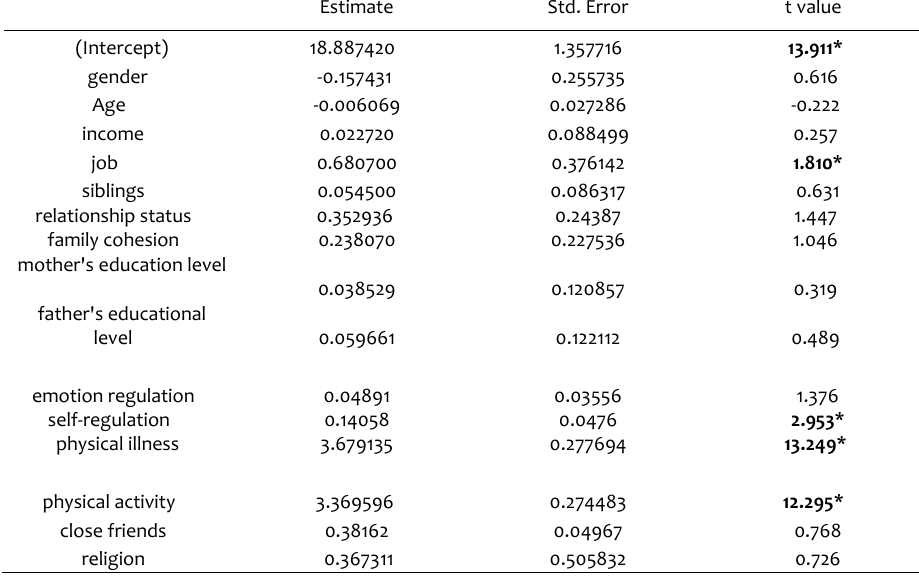
Table 6. Fixed Effects of the Second Model